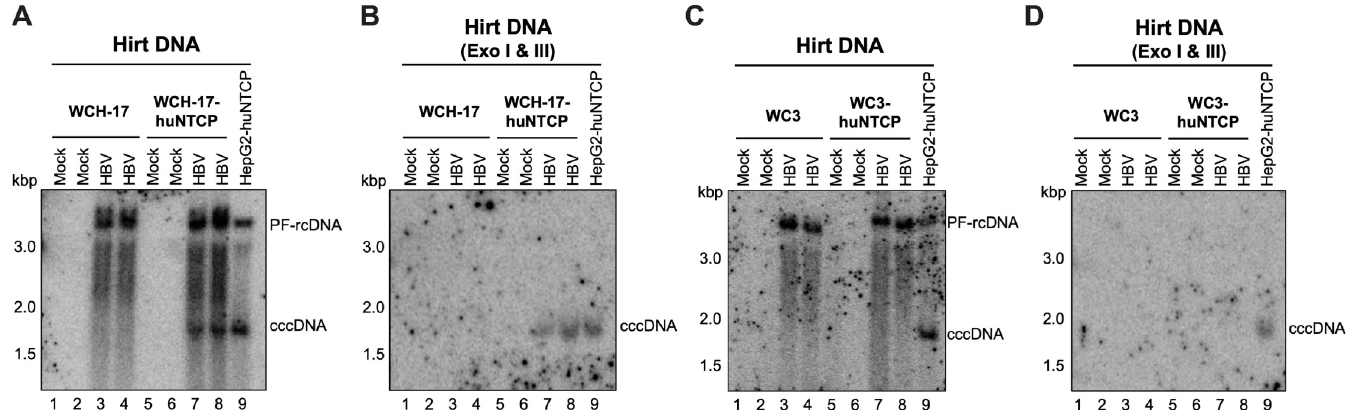
Fig 4. WCH-17 cells were rendered susceptible to HBV infection after huNTCP expression. WCH-17 (A, B) or WC3 (C, D) parental and huNTCP-expressing cells were plated on regular culture dishes (i.e., with no collagen coating) and infected with ca. 400 genome equivalent of HBV per cell. Three days post infection, the PF DNA (i.e., Hirt DNA) from mock- or HBV-infected cells was extracted by Hirt extraction and treated with Exo I/III followed by Southern blot analysis. Hirt DNA from HBV- infected HepG2-huNTCP cells, loaded at 4-fold less than the Hirt DNA from woodchuck cells, served as the positive control for cccDNA detection.